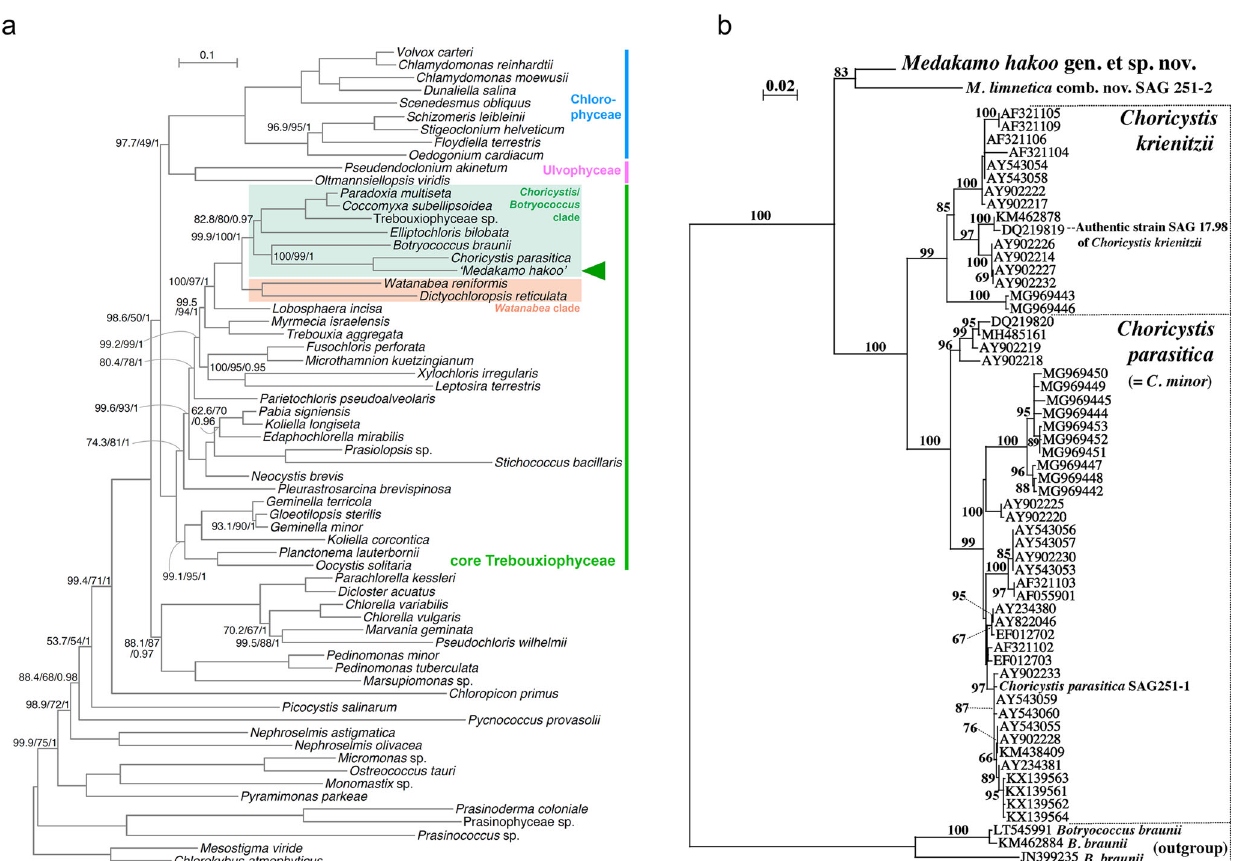
Fig. 2 Evolutionary analyses of the Medakamo hakoo genome. a Phylogeny of 62 chlorophytes inferred using a dataset comprising 15,561 amino acid positions in 79 cpDNA-encoded proteins. The best maximum-likelihood (ML) tree is presented, with support values at the nodes (the approximate likelihood-ratio test support/non-parametric bootstrap support values analyzed by IQ-TREE/posterior probability calculated using PhyloBayes). A lack of values at branches re fl ects 100% support from all analyses. b Phylogenetic relationships between M. hakoo and 54 algal strains identi fi ed as Choricystis species in the NCBI database (https://www.ncbi.nlm.nih.gov/), Choricystis parasitica SAG 251-1 (NIES-1436), and Medakamo limnetica comb. nov. SAG 251- 2 [ = Choricystis limnetica 18 , according to the ML analysis of the chloroplast Rubisco large subunit gene ( rbcL )]. Bootstrap values (50% or higher) for 1000 replications are presented at the branches. Branch lengths are proportional to the evolutionary distances indicated by the scale bar above the tree. Table 2 Comparison of genome data for fi ve microalgal